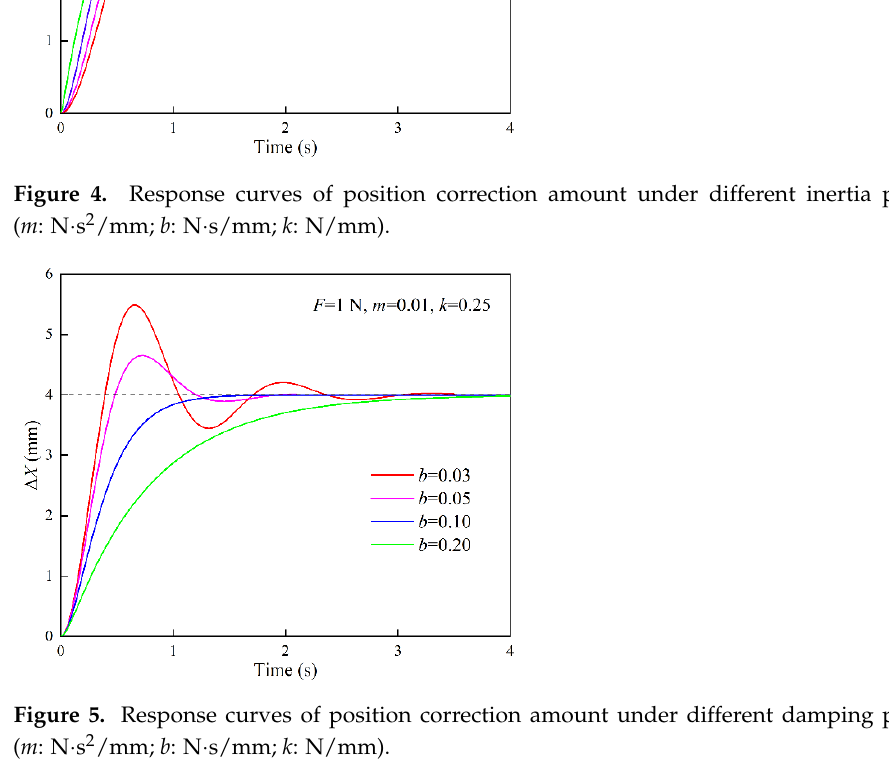
Figure 6. Response curves of position correction amount under different stiffness parameters ( m : N·s 2 /mm; b : N·s/mm; k : N/mm). 4.2. Impedance Control Strategy Simulation When simulating the passive training impedance control strategy, it is necessary to add the impedance control model on the basis of the previous position control simulation. In the simulation environment, the man-machine contact force is set to be: sin